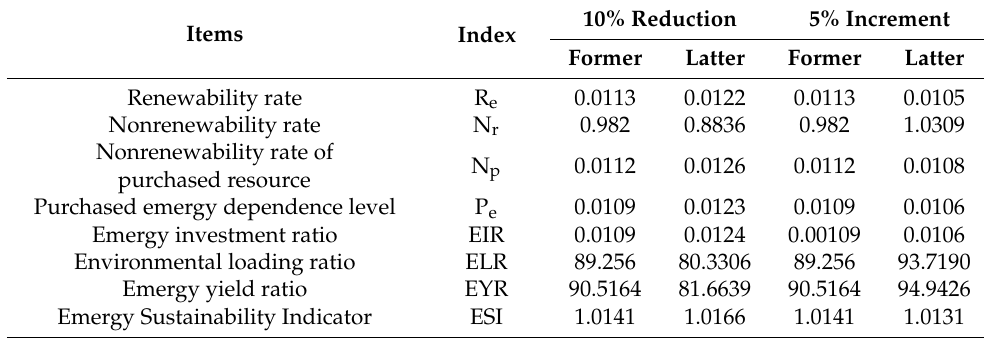
Table 10. Ecological indicator changes between former and latter.